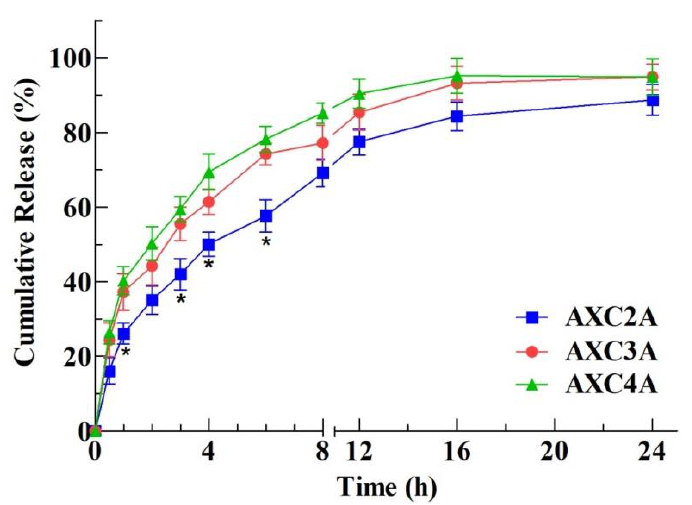
Figure 5. Cumulative AMK release from AMK-loaded AX-CMC films (mean ± SD, n = 3, * p < 0.05).